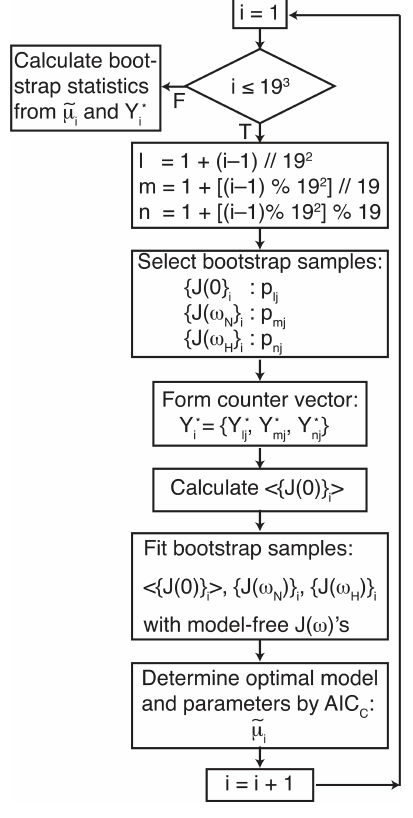
Figure 1. Flow chart for bootstrap aggregation for the model-free formalism. Indices l , m , and n are determined for each bootstrap sample from the index i using modulo arithmetic, in which // rep- resents floor division, and % is the modulo (remainder) operation. The three indices l , m , and n select pointer and counter vectors from Table 1. The three pointer vectors are used to generate bootstrap samples for J (0), J ( ω N ), and J ( ω H ). The three counter vectors are concatenated to form Y ∗ i